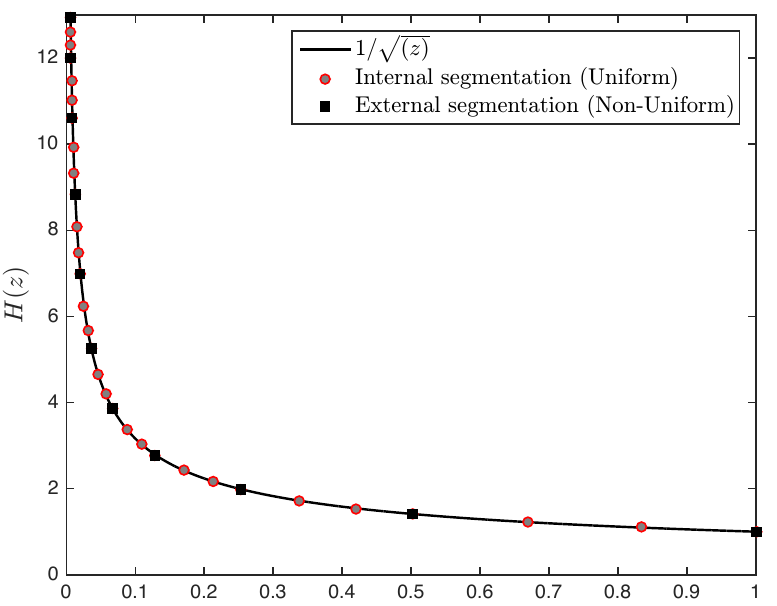
Figure 1. Hybrid segmentation methodology for piecewise polynomial approximation (PPA)